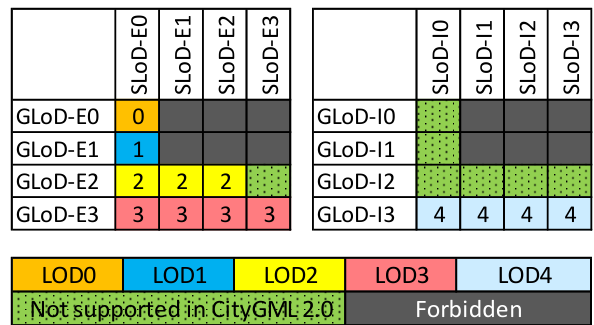
Table 5: Embedding of old LoDs into the new concept